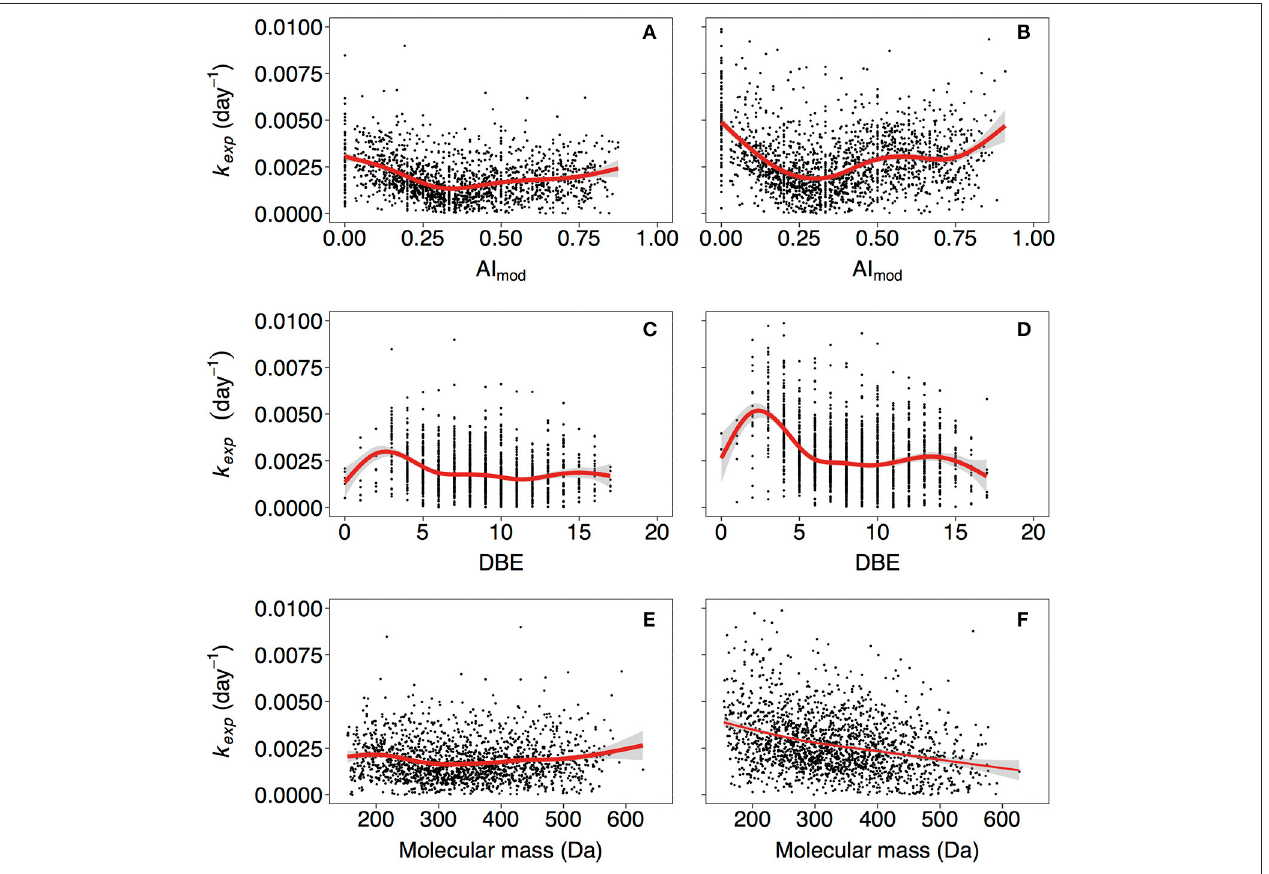
FIGURE 3 | Relationships of k exp with modified aromaticity index (AI mod ; A,B ), double bond equivalence (DBE; C,D ) and molecular mass (E,F) . ( A,C,E , and B,D,F ) correspond to non-manipulated and UV-manipulated treatment, respectively. Red lines correspond to fitted generalized additive models (GAM). The data is shown for one of the duplicates of lake Ramsjön (data for the second duplicate and two other lakes is shown in the Figure